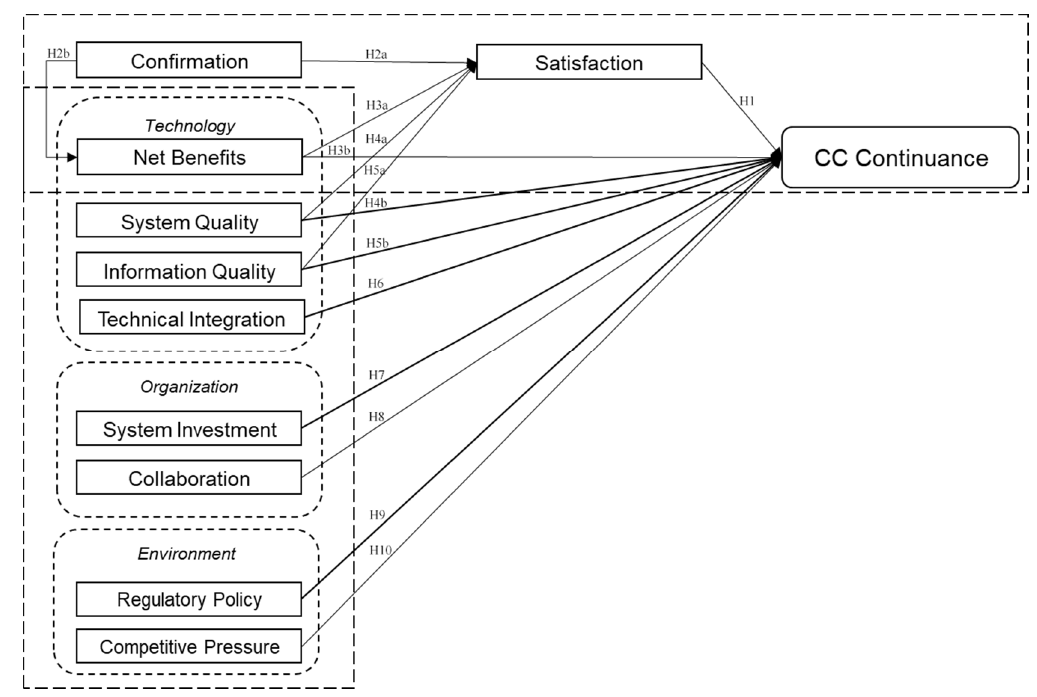
Figure 3. Research Model.